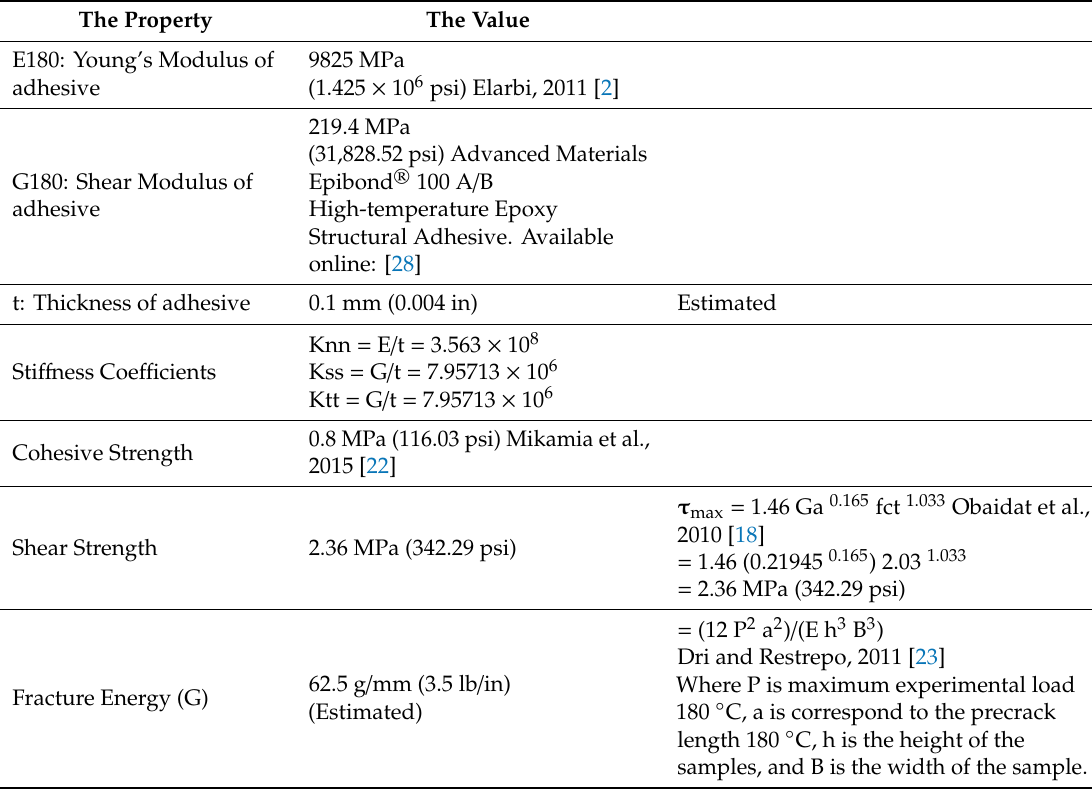
Table 8. Adhesive Properties at 180 ◦